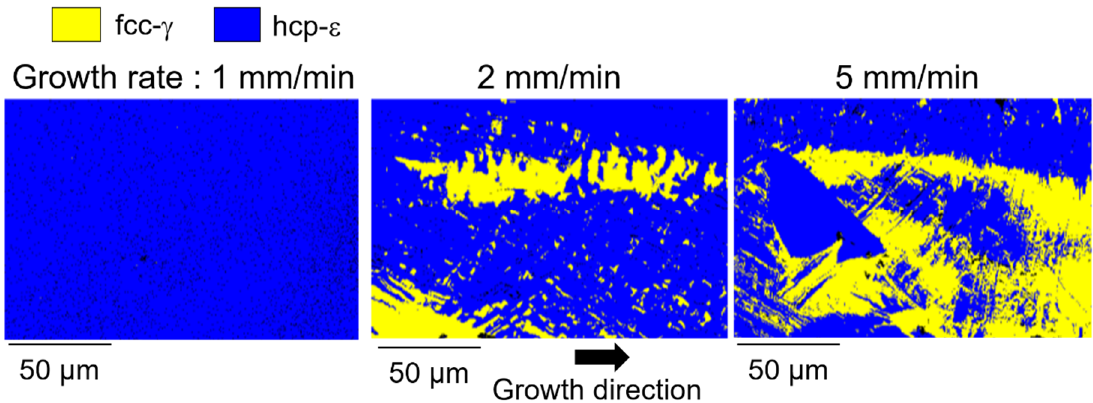
Figure 5. Phase maps along the growth direction on the treated surfaces of the Co-Cr-Mo fibers fabricated at 1, 2, and 5 mm/min growth rates, measured by electron backscattering diffraction (EBSD). Yellow and blue areas are fcc-γ and hcp-ε phases, respectively. Table 1. The ratio of each phase and zero solution in the Co-Cr-Mo fibers.